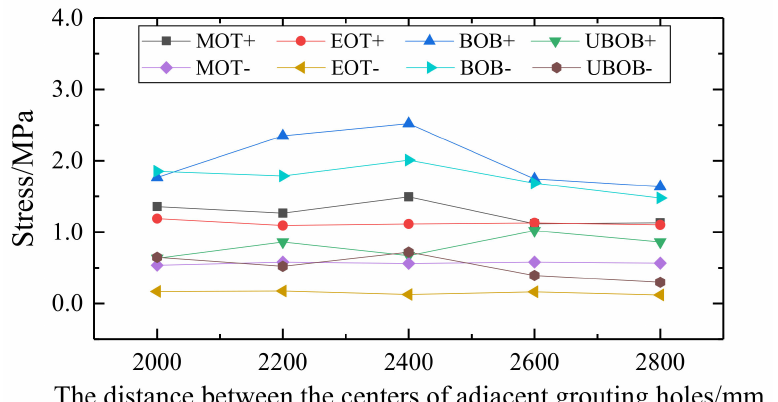
Figure 25. Influence of the distance between the centers of adjacent grouting holes on tempera- ture stress of adjustment layer (In legend identification, “+” means positive temperature gradient; “ − ” means negative temperature